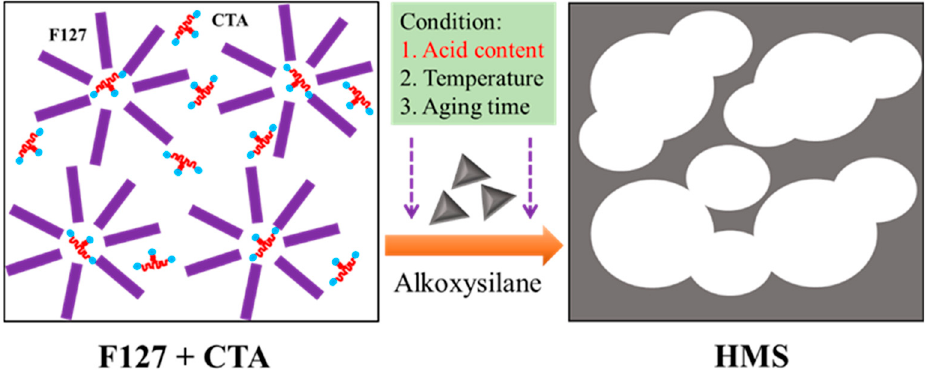
Figure 5. TEM images of HMS calcined at 550